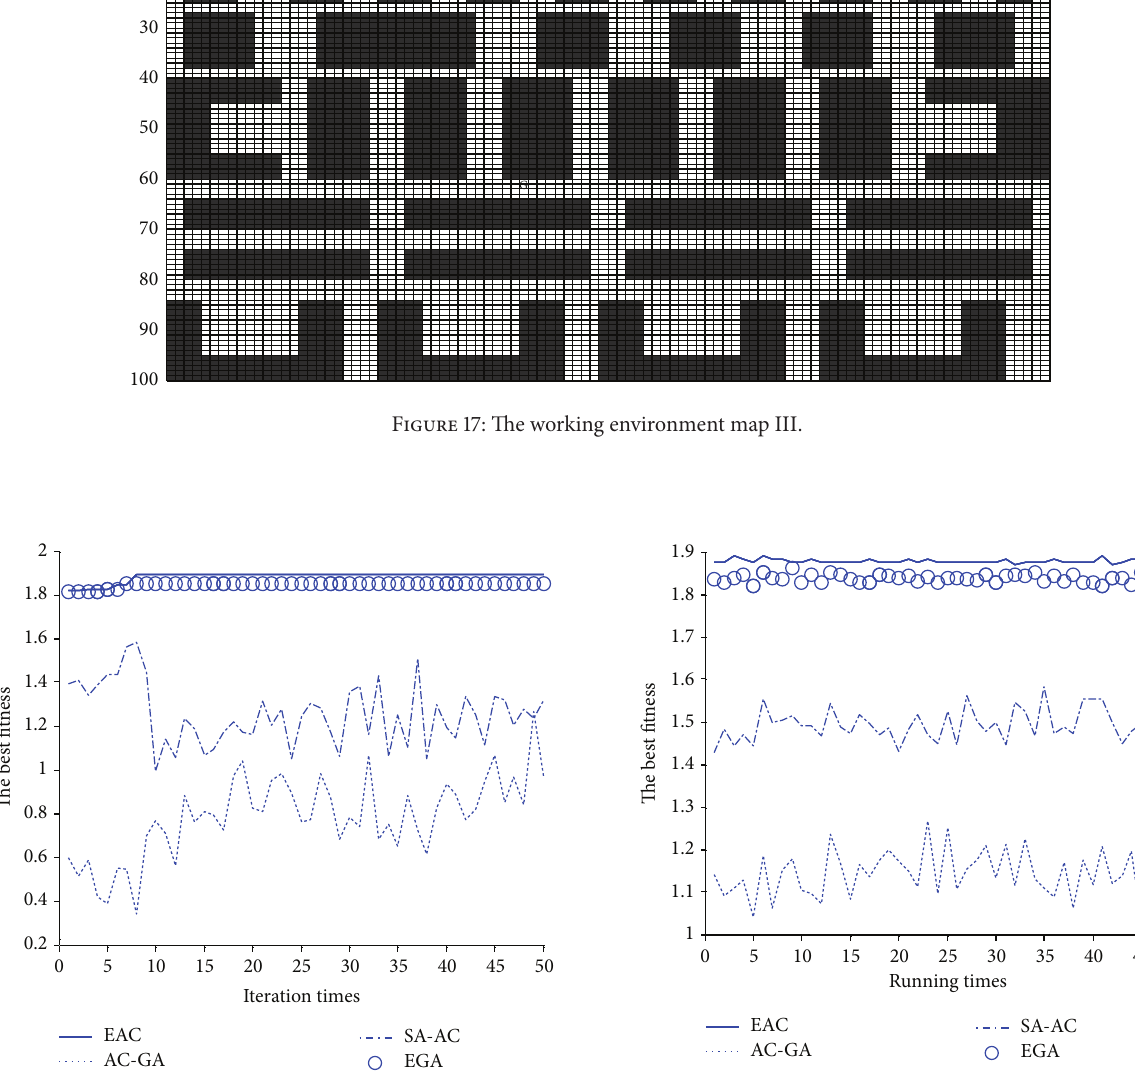
Figure 18: Convergence curves about the optimal fitness on map II.